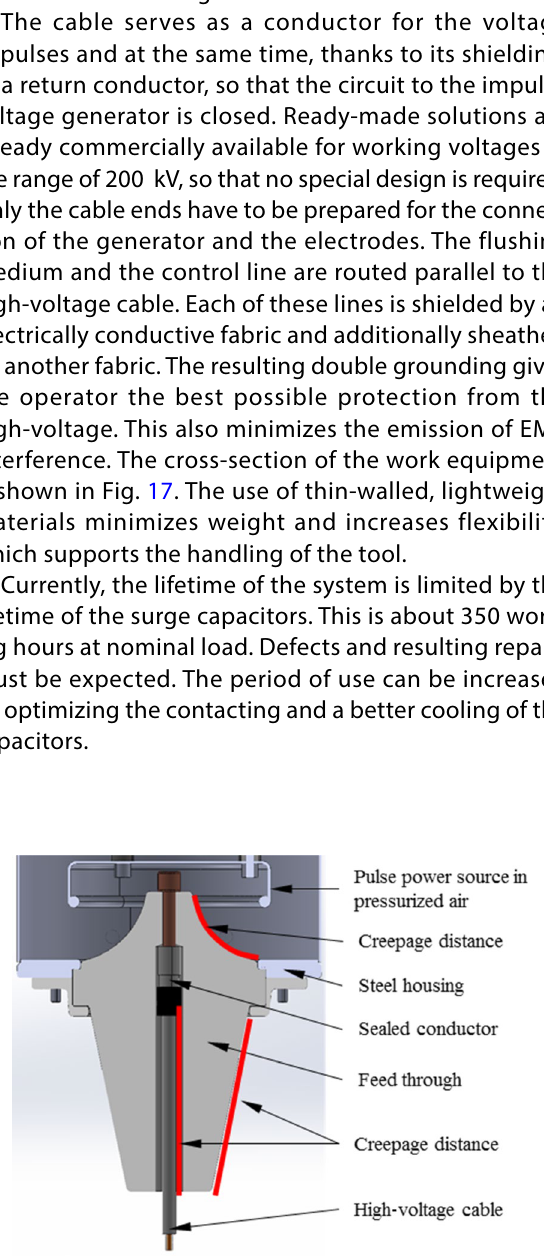
Fig. 16 Insulation setup